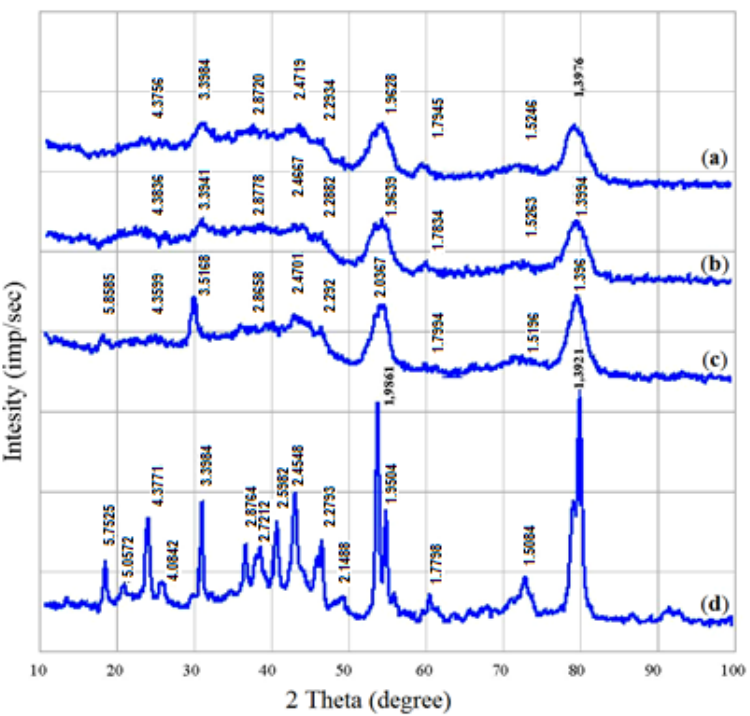
Figure 2. X-ray diffraction patterns of 10% V/Al 2 O 3 catalyst under different heat-treatment modes: ( a ) initial system; ( b ) heating at 400 °C; ( c ) heating at 600 °C; ( d ) heating at 700 °C. Diffraction maxima from Al 2 (SO 4 ) 3 (5.86; 3.51–3.52; 2.03; ASTM 30-43) appear addi-